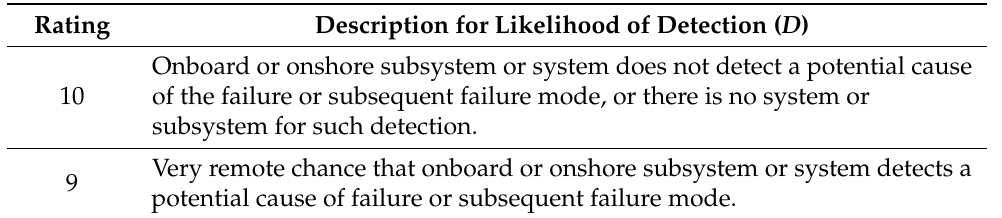
Table 4. Ratings for the detection of a failure mode for a MASS